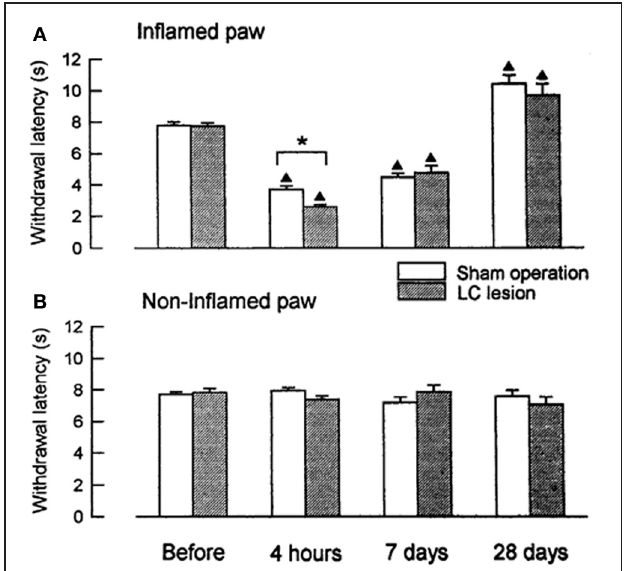
FIGURE 2 | The effect of naloxone or saline on PWLs in sham-operated rats tested 4h, 7 days and 28 days after the injection of carrageenan. The data were obtained 10min after intraperitoneal (i.p.) naloxone ( n = 8) or saline ( n = 8) and are presented for both the inflamed (A) and the contralateral non-inflamed (B) paws. (cid:2) P < 0.01, significantly different from PWLs before injection. ∗ P < 0 . 01, significantly different between two groups of rats (Tsuruoka and Willis, 1996b).